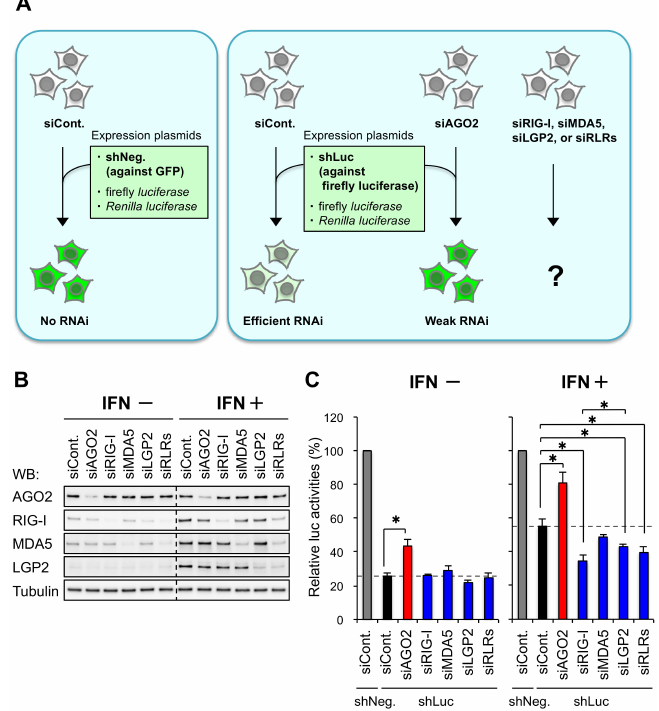
Figure 1. Retinoic acid-inducible gene I (RIG-I) and laboratory of genetics and physiology 2 (LGP2) repress short hairpin RNA (shRNA)-induced RNA interference (RNAi) in human HeLa cells. ( A ) Experimental scheme of shRNA-induced RNAi activity assay. Plasmids encoding shRNA against GFP (shNeg.) or firefly luciferase (shLuc) was transfected with plasmids encoding firefly luciferase